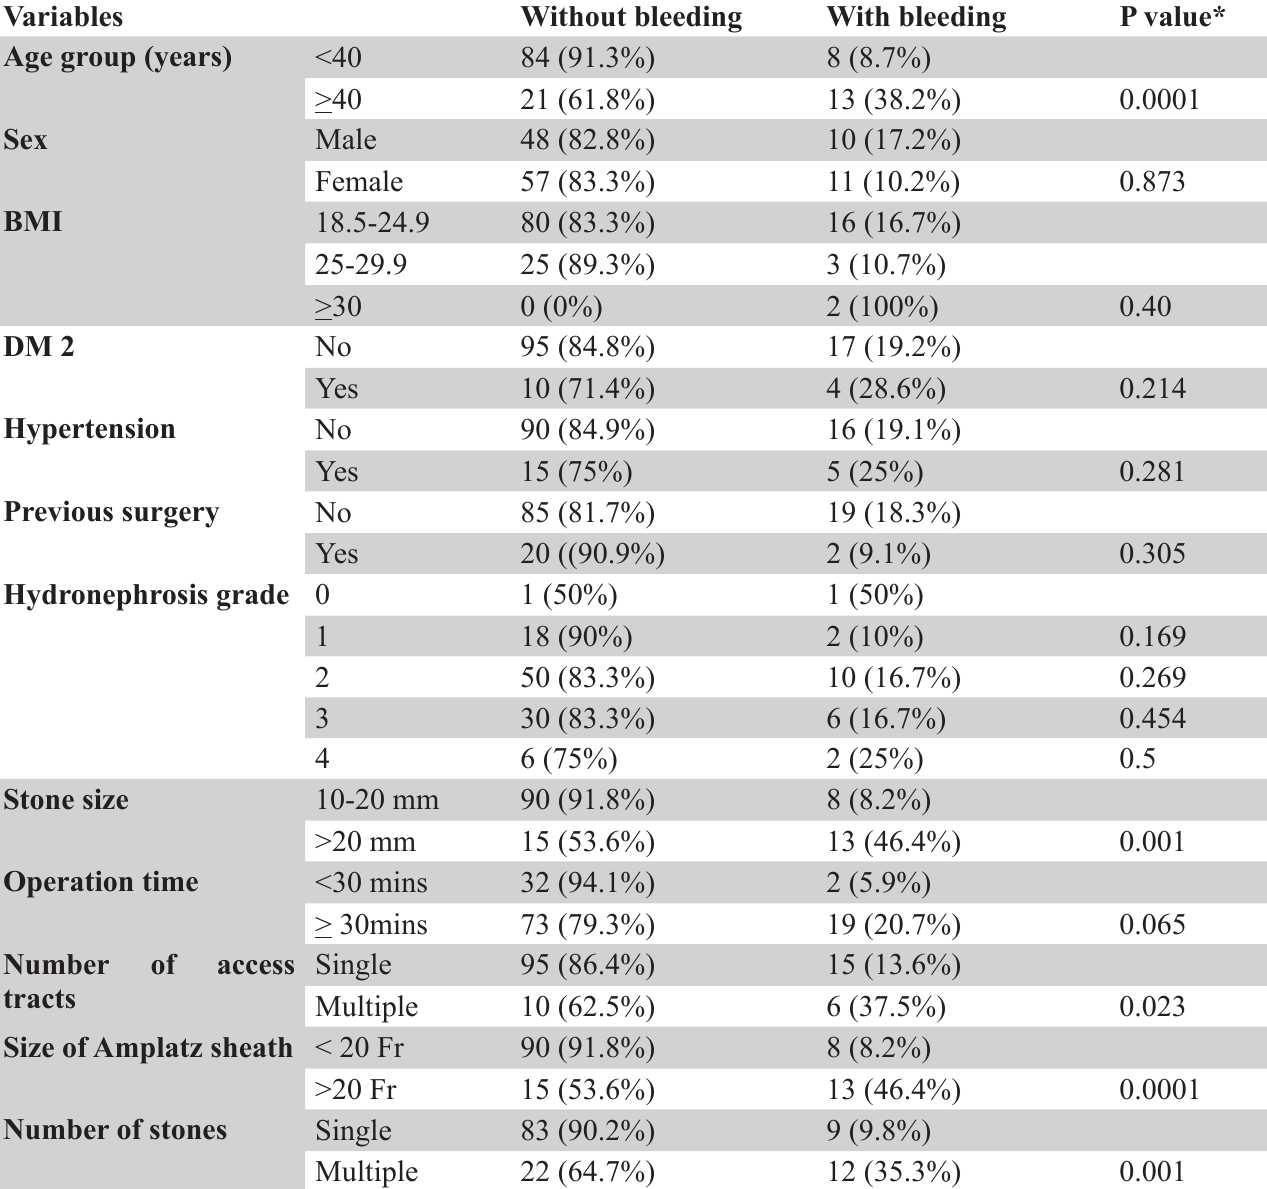
Table 2. Univariate analysis of factors affecting blood loss (N=126) Variables Without bleeding With bleeding Age group